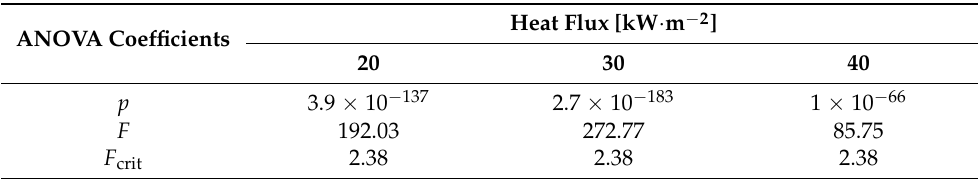
Table 7. Results of ANOVA examining the impact of wood species on the combustion efficiency